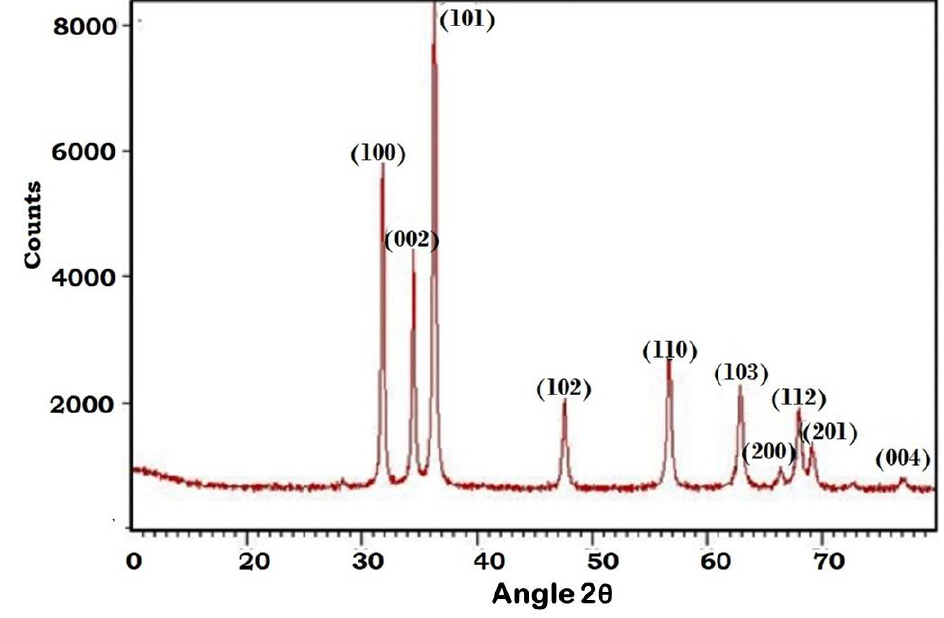
Figure 2. X-ray diffraction curves of green synthesized ZnO nanoparticles. other